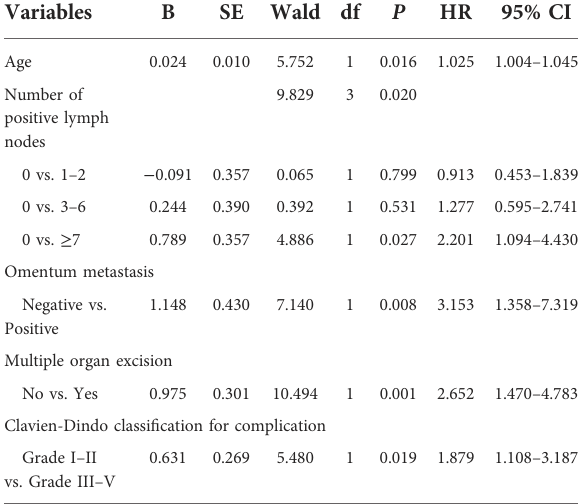
TABLE 2 Multivariate analysis of OS of training cohort of chemotherapy cycle <9 and analyzed by Cox